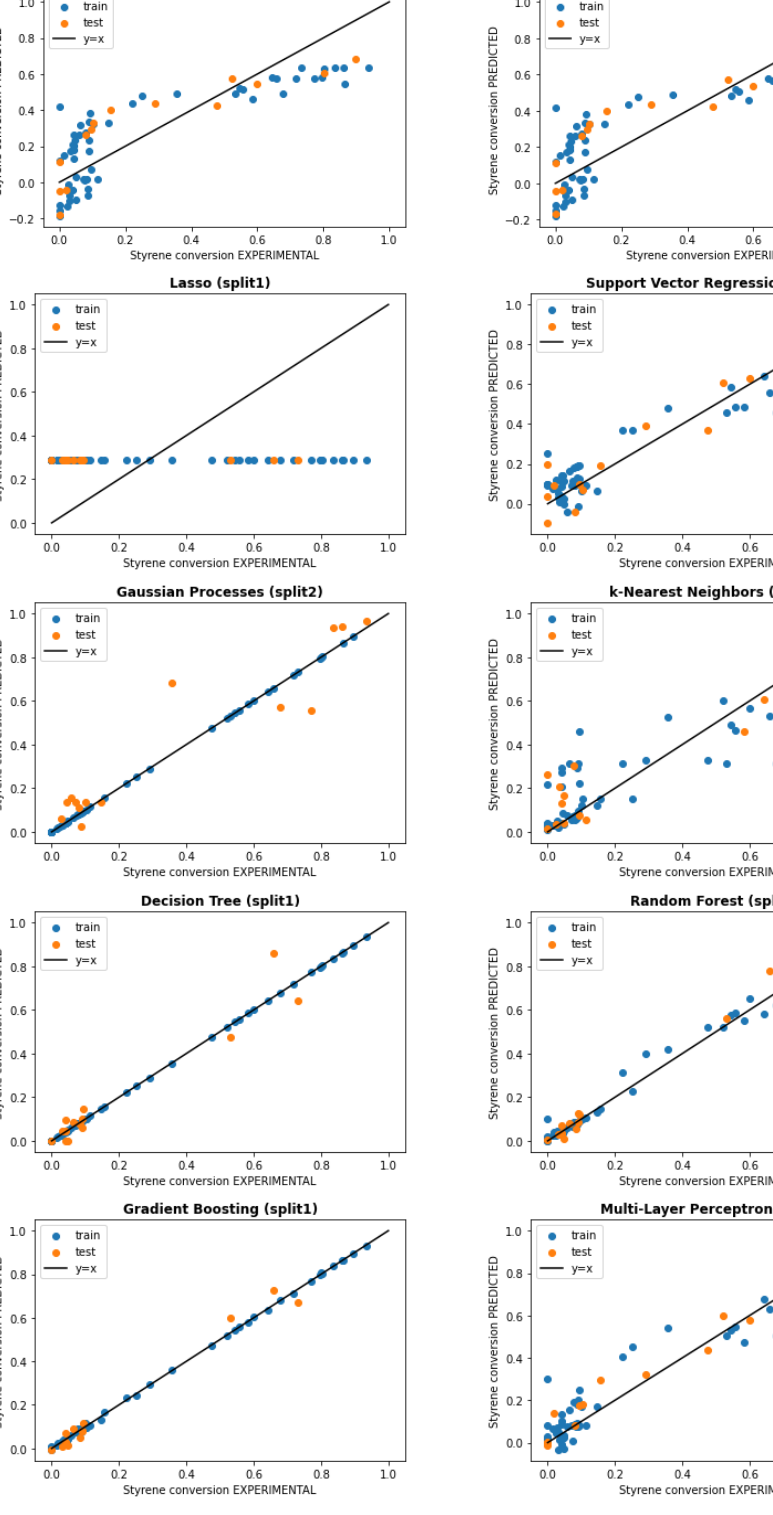
Figure 9. Parity plots of the ten screened models (without HP